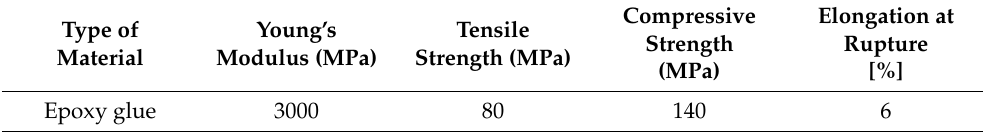
Table 5. The material data of the epoxy adhesive.